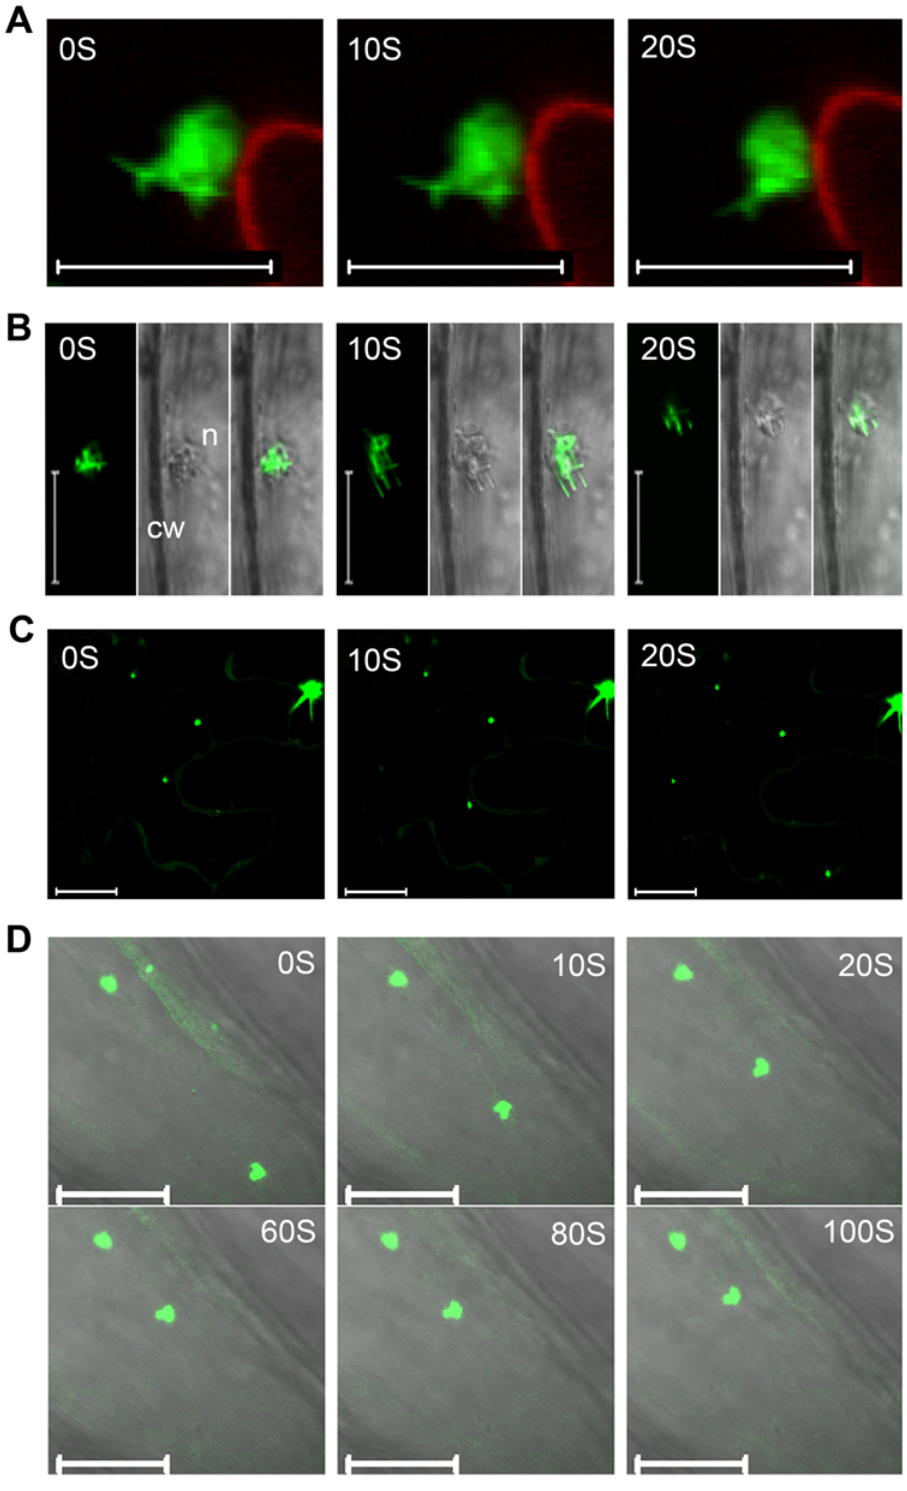
Figure 6. Motility of VER2-GFP fusion protein in Arabidopsis leaf epidemis and veins. (A) VER2-GFP involved nuclear movement in epidermal cells. PI-stained cell wall was shown in the red channel. (B) VER2-GFP involved nuclear movement in vein cells. (C) Movement of punctate- located VER2-GFP in leaf epidermal cells. (D) Temporal dynamics of VER2-GFP targeted to punctuate structures in vein cells, showing merged images of fluorescence and corresponding transmitted images. n, nuclei; cw, cell wall. Bars, 20 m m.